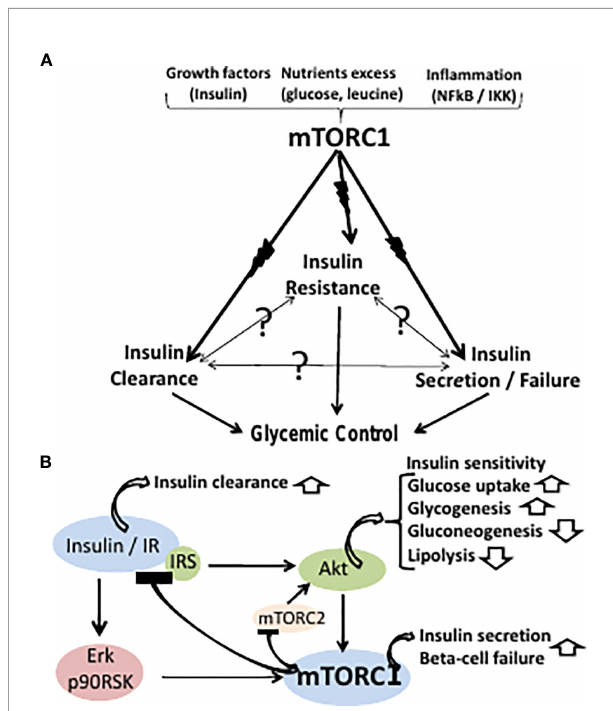
FIGURE 1 | (A) The classical paradigm of T2D glycemic control maintains a cause-effect relationship between insulin resistance, secretion and clearance. However, the cause-effect paradigm is still unresolved (symbolized by question marks) in terms of molecular modes-of-mediation. The three effectors of